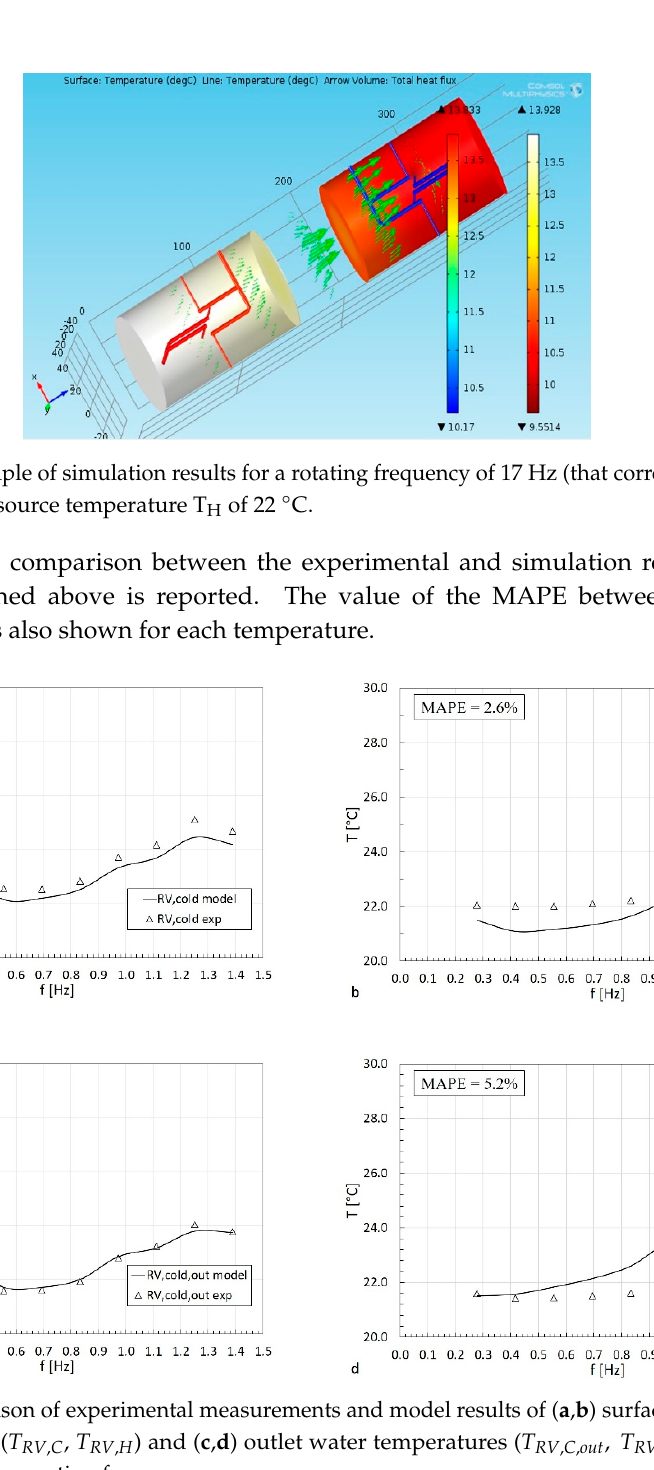
Table 3. Absolute and relative error of the thermal model.